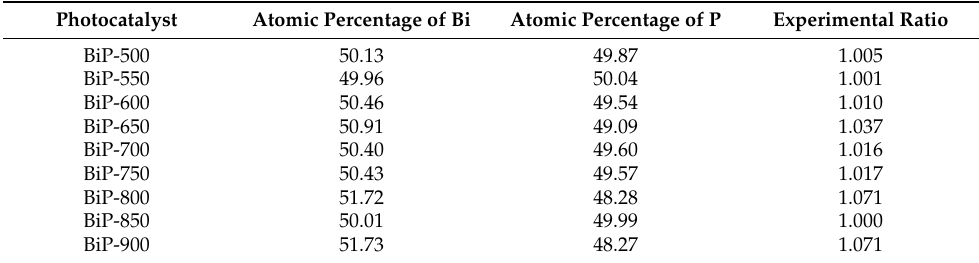
Table 3. EDX analyses for Bi and P